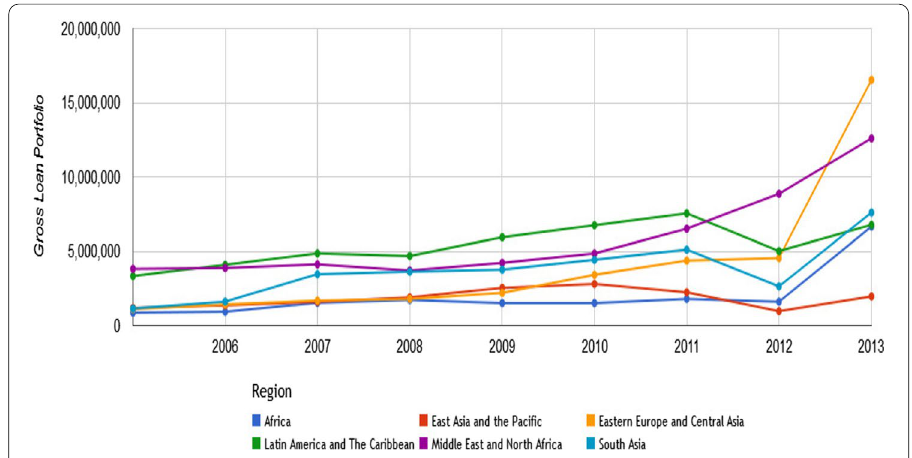
Fig. 1 Trends and patterns of real gross loan portfolio. Source: Authors’ compilations from MIX data